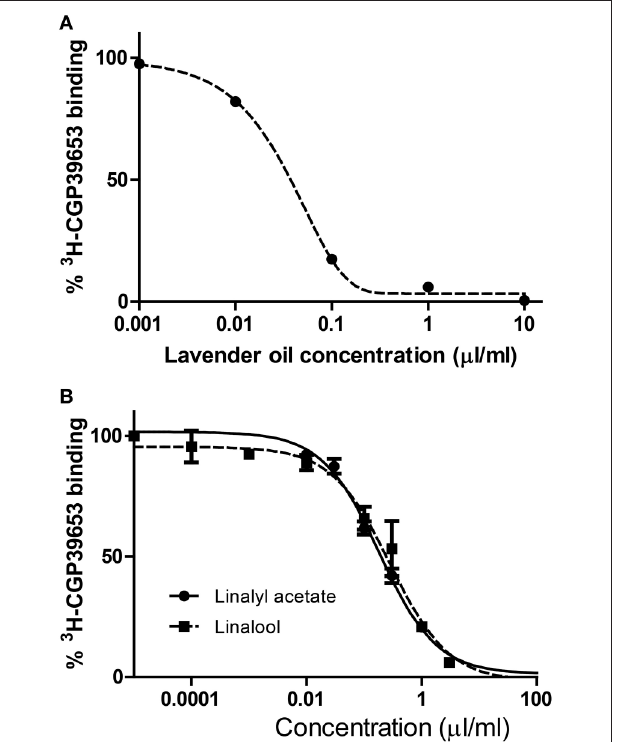
FIGURE 2 | Affinity of lavender essential oil (A) and linalool and linalyl acetate (B) for the glutamate NMDA receptor. The displacement studies of [ 3 H]CGP39653 were performed on membranes obtained from rat brain homogenates. TABLE 2 | IC 50 and K i values of lavender essential oil (LEO) and monoterpenes in the [ 3 H]CGP39653 binding assay. Essential